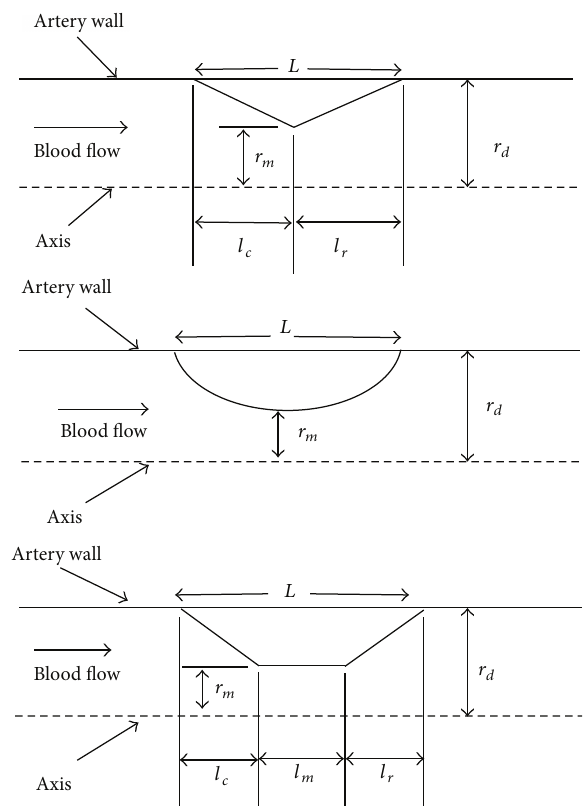
Figure1:Schematicdiagramfortriangular,elliptical,andtrapezium lesion